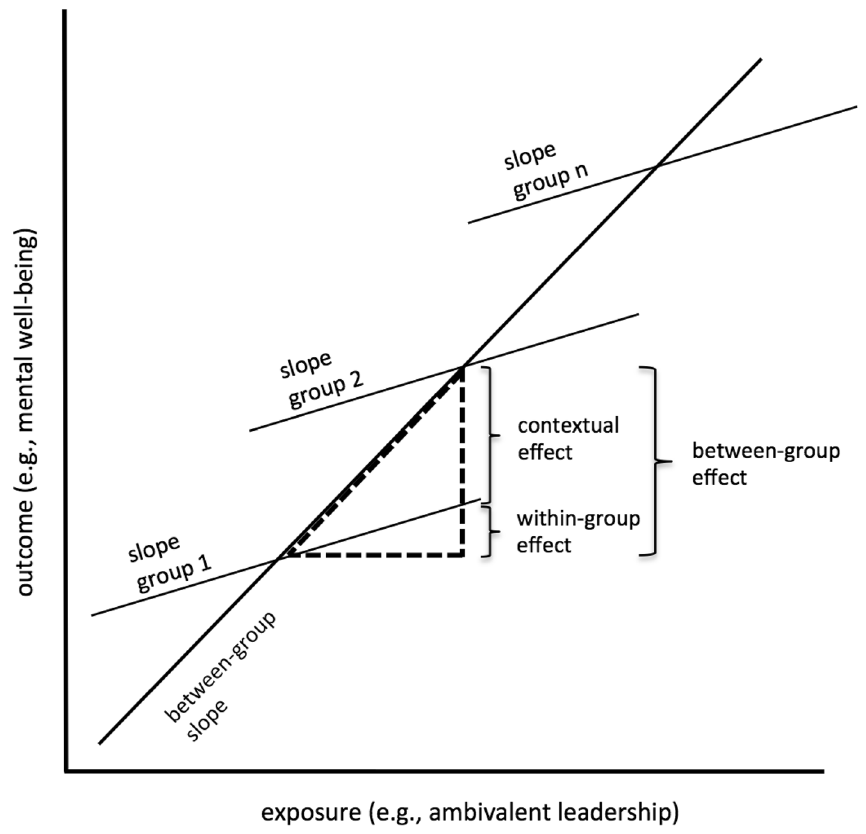
Figure 2. Conceptual description of within-group effects (i.e., mental health among employees that belong to the same work group as predicted by their ambivalent leadership perceptions), between-group effects (i.e., mean levels of mental health of work groups as predicted by the group-mean ambivalent leadership perceptions), and contextual effects (i.e., mental health of employees that have the same ambivalent leadership rating, but belong to work groups that differ in their mean ambivalent leadership ratings). This contextual effect is demonstrated by significant heterogeneity (Hausman